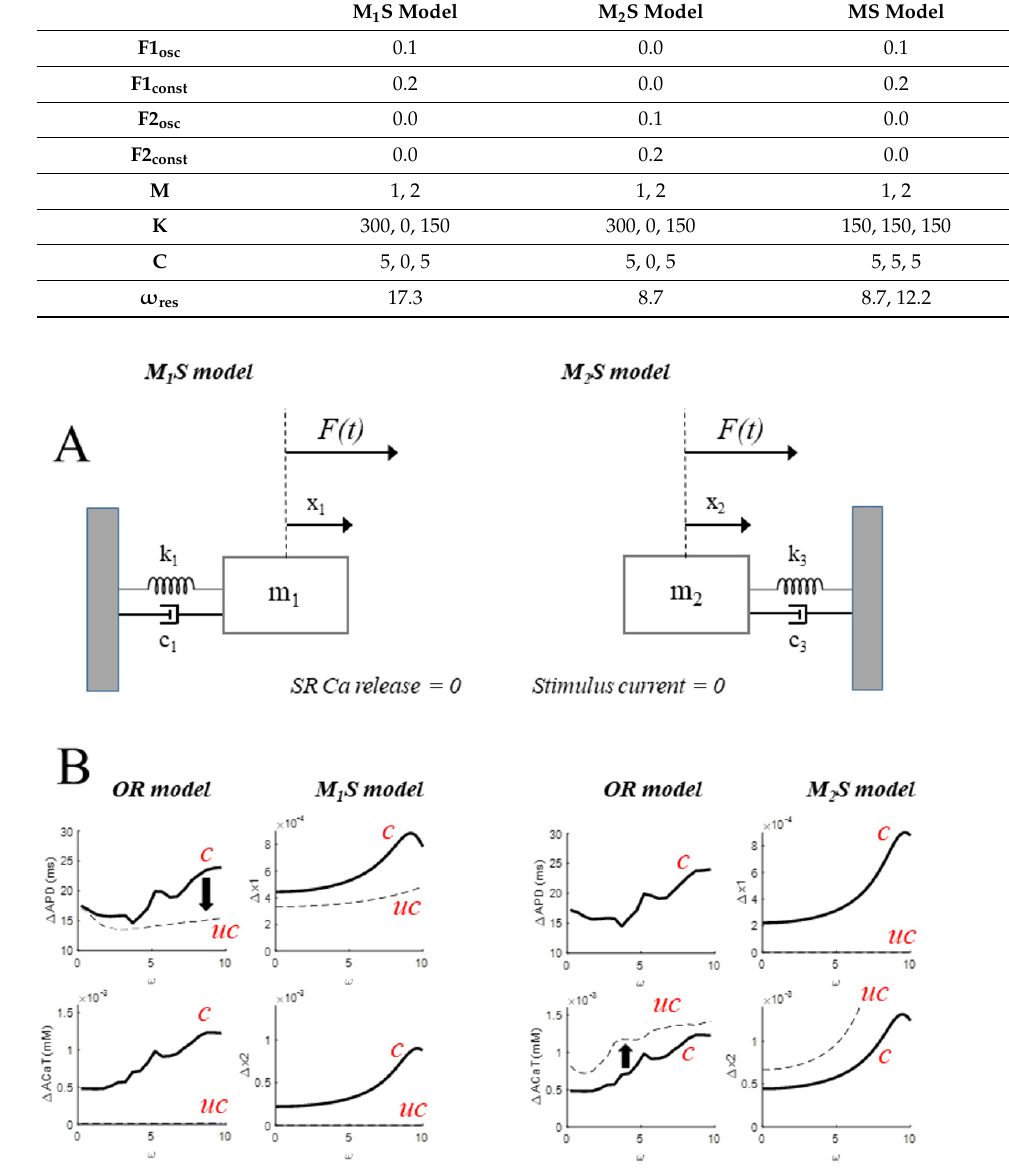
Figure 7. Comparison between coupled and uncoupled oscillations. ( A ): When the source of the calcium oscillations is removed by turning SR calcium release off, we hypothesize that the MS model is reduced to a single mass-spring oscillator (left ). Same in the case of removal of el-C oscillations by turning stimulus current off ( right ). ( B ): The ω dependence of Δ APD and Δ CTA oscillations at high pacing frequency is reported in first and third columns as a bold line, under SVP following Equation (1) (BCL = 300 ms, σ = 50 ms, 0 < ω < 10). First and third columns show the effects (broken lines) on both parameters of the complete removal of SR release and membrane excitation, respectively, under the same pacing conditions. Second and fourth columns show the behavior of the MS model in coupled (k 2 and c 2 ≠ 0, solid line) and uncoupled (k 2 and c 2 = 0, solid line) conditions under external sinusoidal forcing. Parameters of the coupled and uncoupled MS model are reported in Table 1. Red labels c and uc stand for coupled and uncoupled state of the two separate oscillators. Table 1. Parameters of the MS model. Model’s parameters in the case of M 1 S (Figure 7A left), M 2 S (Figure 7A right), and MS (Figure 7C). Oscillating (F1 osc , F2 osc ) and constant (F1 const , F2 const ) compo- nents of the external force driving mass 1 (m 1 ) and mass 2 (m 2 ), vector of the two masses (M), vector of the three stiffness constants (K), vector of the three damping constants (C), and resonant frequen- cies of the three systems.